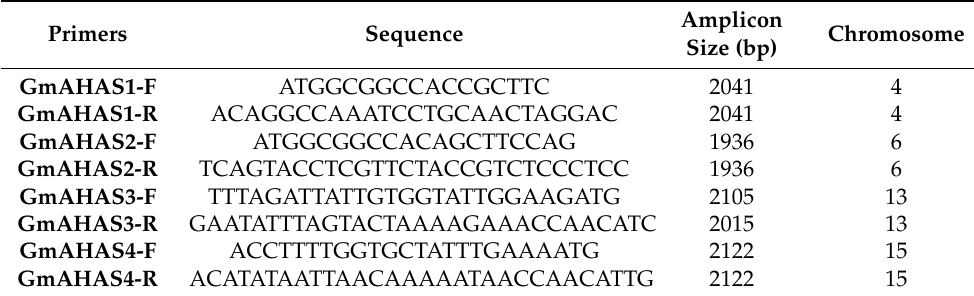
Table 1. Primers used to amplify the AHAS